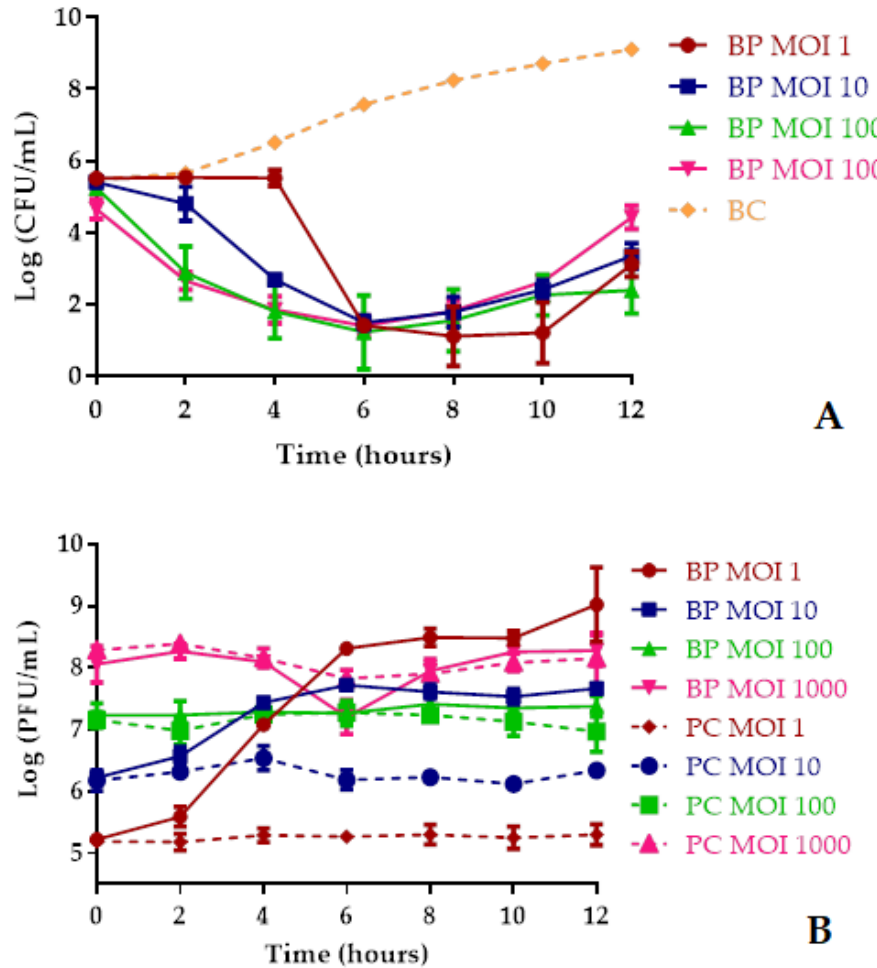
Figure 6. Inactivation of A. hydrophila by phage AH-1 at MOIs of 1, 10, 100, and 1000 during 12 h. ( A ) Bacterial concentration: BC, bacteria control; BP, bacteria plus phage. ( B ) Phage concentration: PC, phage control; BP, bacteria plus phage. Values represent the mean of the three independent experiments and error bars represent the standard deviation.